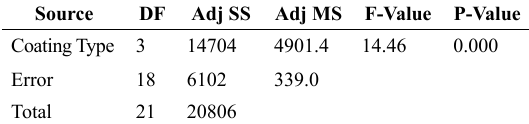
Table 5. ANOVA test results of the critical pitting potential (E versus coating type.